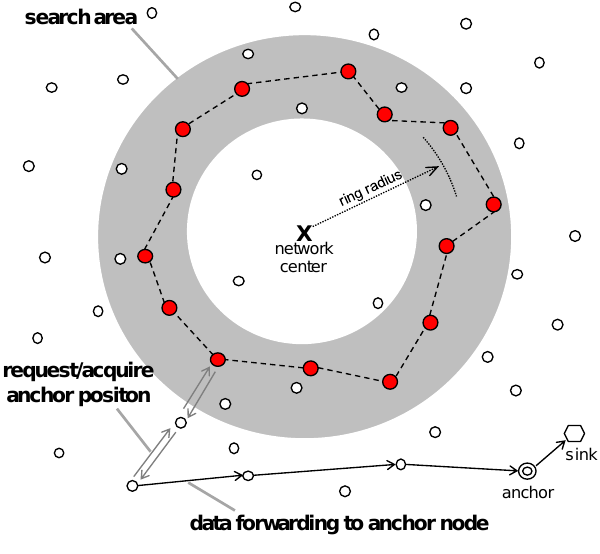
Figure 1. Overview of the ring routing [5]